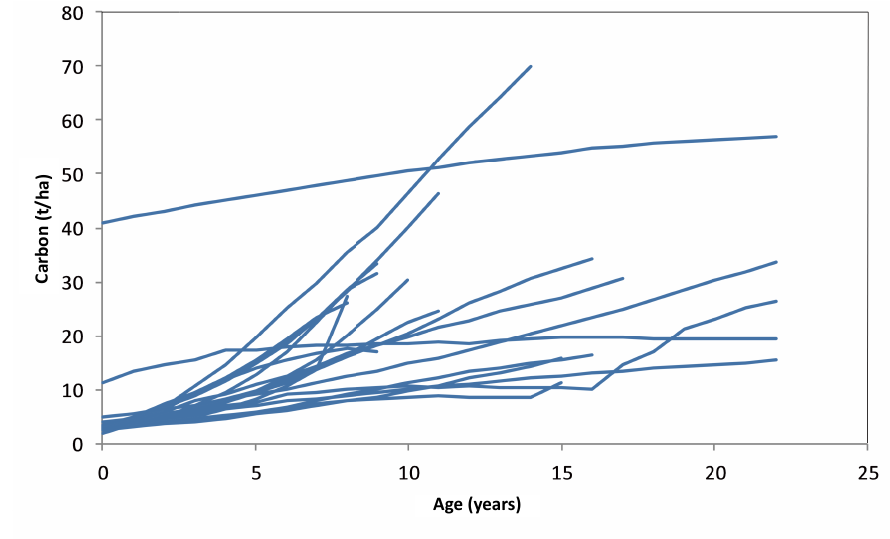
Figure 2. Carbon stock vs. age (threshold method) for each